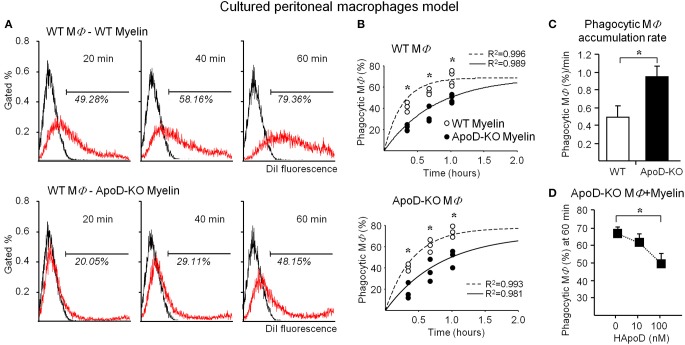
ApoD alters the phagocytosis of myelin by cultured peritoneal macrophages. (A) Myelin phagocytosis by TG-elicited macrophages measured with flow cytometry after different times of exposure to myelin of WT or ApoD-KO mouse brains. Histograms of a representative experiment in WT macrophages are shown. The histogram of control macrophages without myelin defines the fluorescence threshold to classify an event as a DiI-positive macrophage. (B) Flow cytometry evaluation of myelin phagocytosis by TG-elicited macrophages (WT macrophages, upper panel; KO macrophages, lower panel). Dots in graphs represent average ± SD of 3–4 independent experiments (with 3 macrophage samples per experiment) performed with two myelin preparations/genotype, each purified from 1 to 2 mouse brains. Curve fitting was performed following a single exponential and setting a maximal phagocytosis at 5 h following (Slobodov et al., 2001). ApoD-KO myelin delays macrophage phagocytosis independently of the macrophage genotype. (C) Slope of data shown in B for WT and ApoD-KO macrophages, representing the accumulation rate of DiI-positive macrophages. (D) The exogenous addition of purified human ApoD to ApoD-KO TG-elicited macrophages rescues the WT levels of myelin phagocytosis in a concentration dependent manner. Statistical differences were assayed by ANOVA followed by a Multiple Comparison Holm-Sidak test (B), and Student's t-Test (C,D). Asterisks show statistically significant differences (P < 0.05).